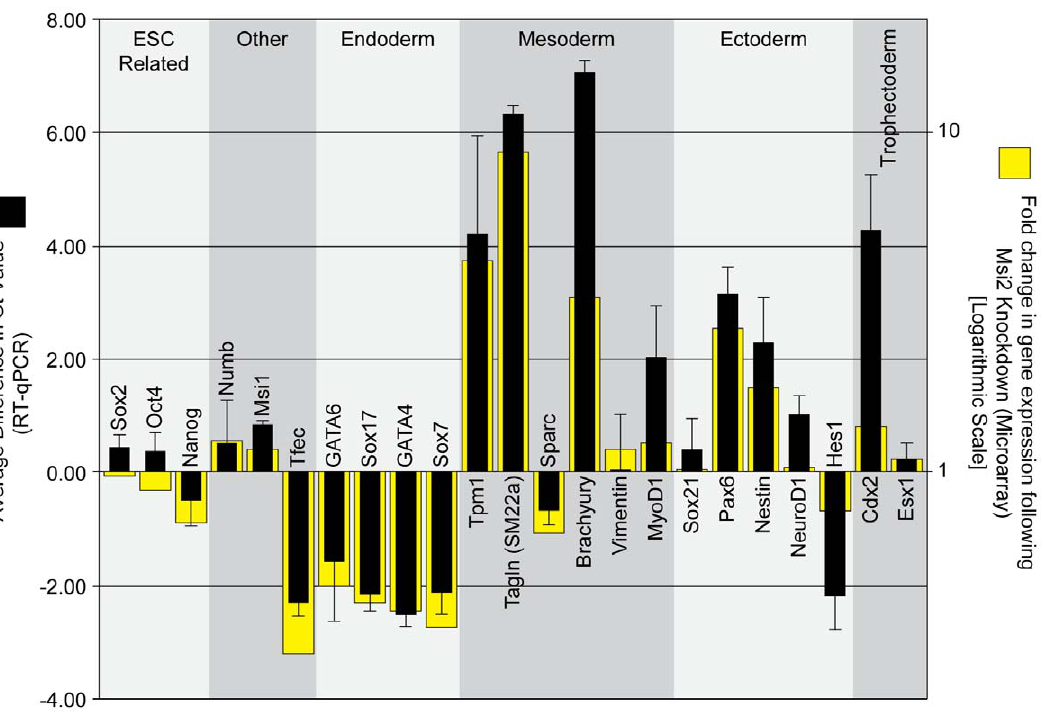
Figure 4. Knockdown of Msi2 in ESC leads to the expression of lineage-specific markers. Seven days post-infection, RNA was isolated from the D3 ESC infected with lentiviruses that express either the scrambled (Scr) shRNA sequence or the Msi2 shRNA # 1 sequence. Microarray analysis was used to assess global changes in gene expression (Fig. S2A). RNA expression for a select set of genes (yellow bars) is indicated as fold change, where a value . 1 represents an increase in expression in cells treated with shRNA # 1. All microarray data is available on Gene Expression Omnibus (Accession No. GSE33882, GEO, http://www.ncbi.nlm.nih.gov/geo/). Expression of this gene subset was verified by RT-qPCR (black bars). Threshold cycle (Ct) values were calculated by normalizing all Ct values to GAPDH then subtracting the Ct value for cells infected with Msi2 shRNA # 1 from the Ct value for cells infected with the scrambled shRNA lentivirus. A positive Ct value indicates an increase in the level of the transcript in the Msi2 knockdown cells. Multiple rounds of RT-qPCR were used to calculate an average change in Ct value, and error bars represent standard deviation.